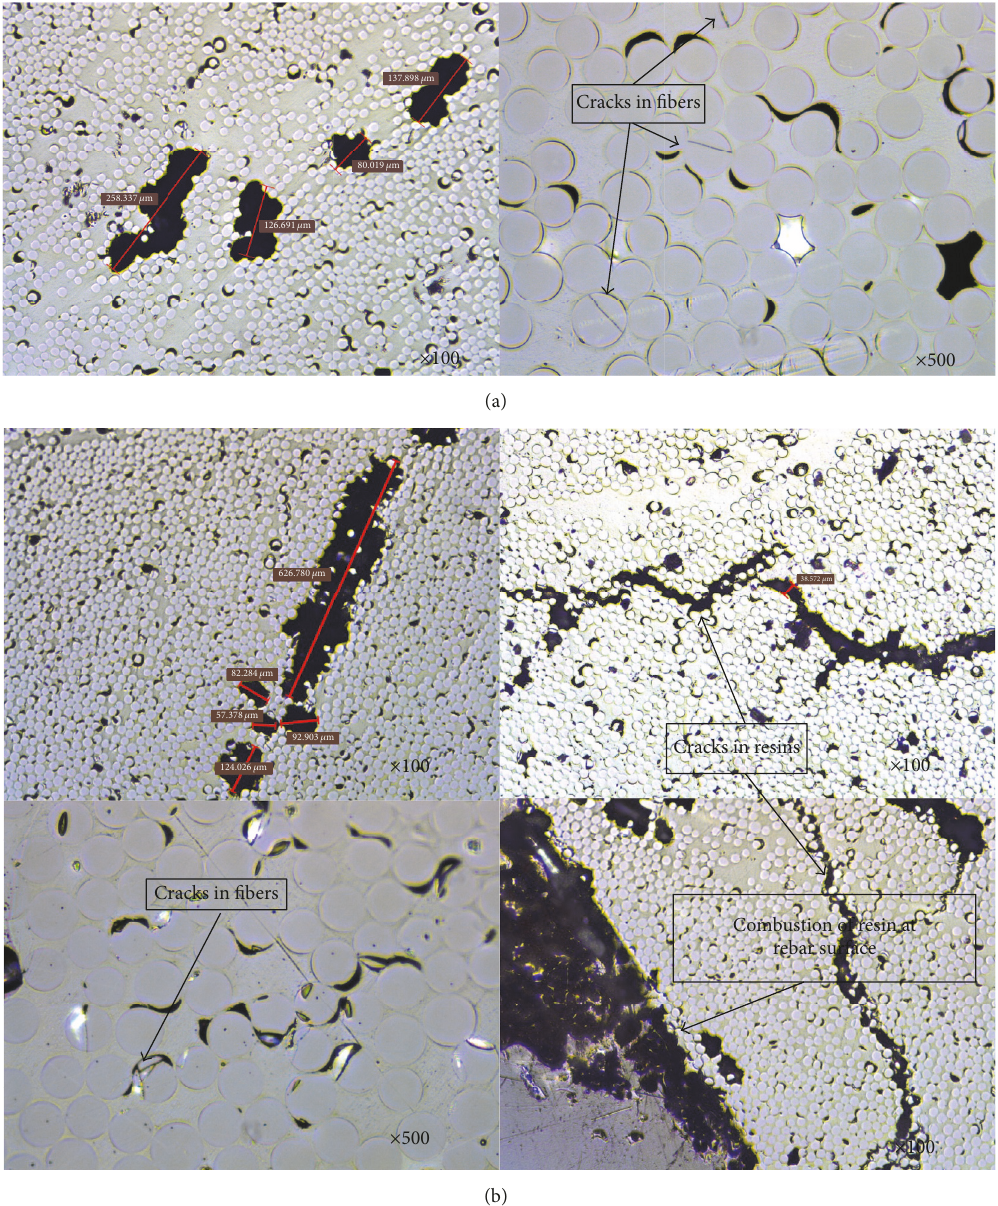
Figure 17: Optical microscopic images after immersing into alkaline solution for 30 days: (a) PH 120 and (b) PH 200 specimens.